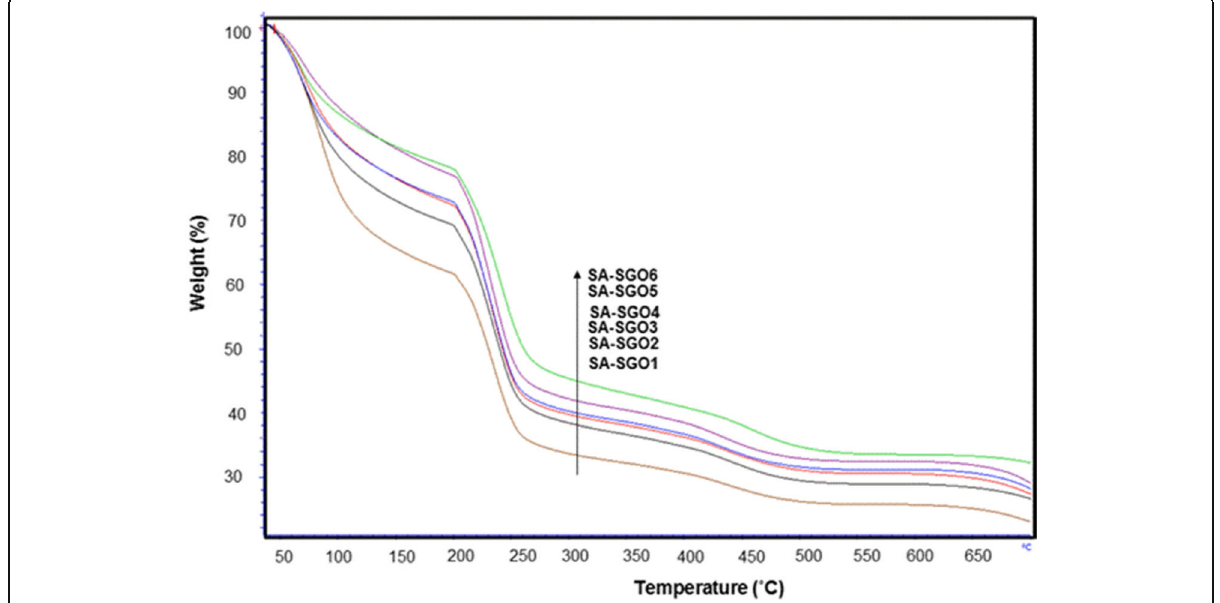
Fig. 7 TGA curve for SA/SGO biomembranes with various SGO